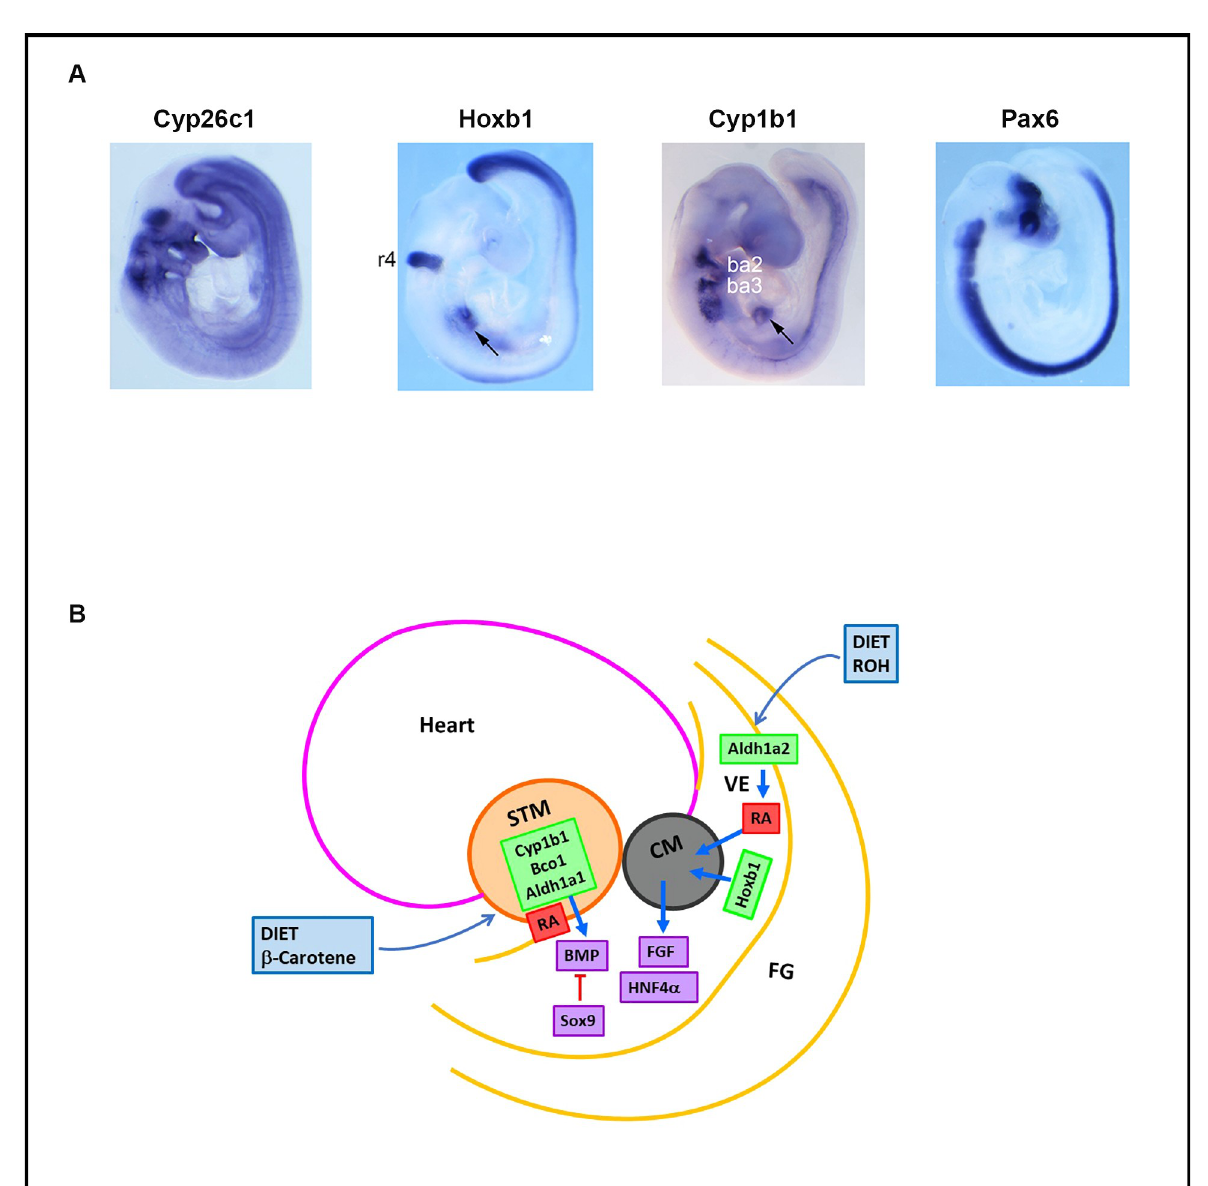
Fig 5. Sites of expression of Cyp1b1 and Hoxb1 in WT E9.5 embryos. E9.5 WT embryos from dams administered a vitamin A-sufficient diet were stained by ISH to reveal Cyp26c1 , Hoxb1 , Cyp1b1 , and Pax6 mRNAs. Lateral views are shown. Noted are hindbrain rhombomere 4 (r4), branchial arches (ba), foregut (ventral endoderm)/septum transverse mesenchyme (STM) (arrow) structures (A). Diagram of foregut (FG) region of liver budding showing positioning of Heart (H), STM and CM (cardiac mesoderm) and ventral endoderm (VE). Sites of expression of Cyp1b1 , Bco1 (STM) and Hoxb1 (VE). Fgf forms are released from CM, and BMP4 from STM, each supporting hepatoblast expansion (Hnf4a). Sox9 marks the posterior region that develops into pancreas (B).